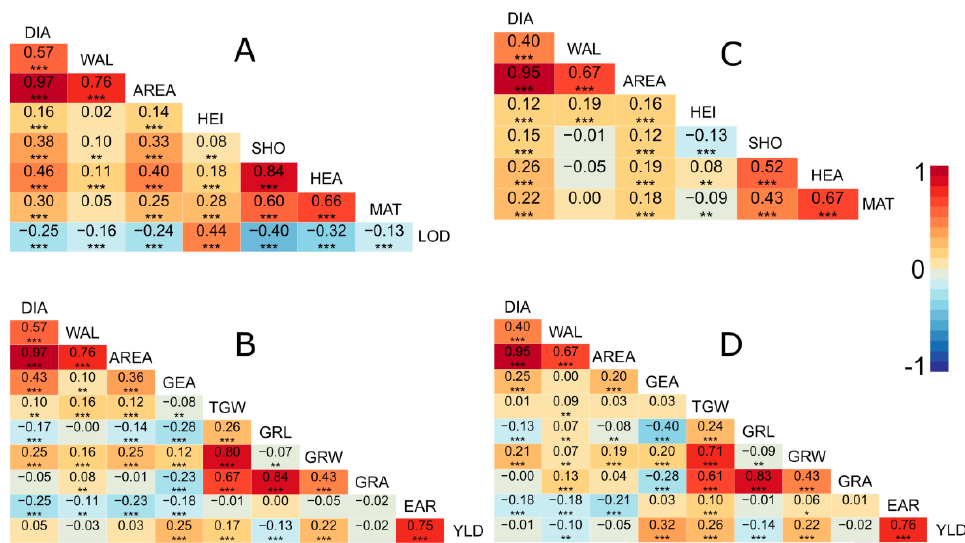
Figure 2. Correlation chart (Pearson correlation coefficients) of peduncle traits with developmental traits 2017 ( A ) and 2018 ( C ) and yield traits 2017 ( B ) and 2018 ( D ). The heatmap coloring indicates the correlation strength. Asterisks indicate the significance level (* p < 0.05, ** p < 0.01, *** p < 0.001). Autocorrelations of traits between years were 0.57 ( p < 0.001) for DIA, 0.37 ( p < 0.001) for WAL and 0.51 ( p < 0.001) for AREA. Abbreviations: HEI: Plant height, SHO: Time to shooting, HEA: Time